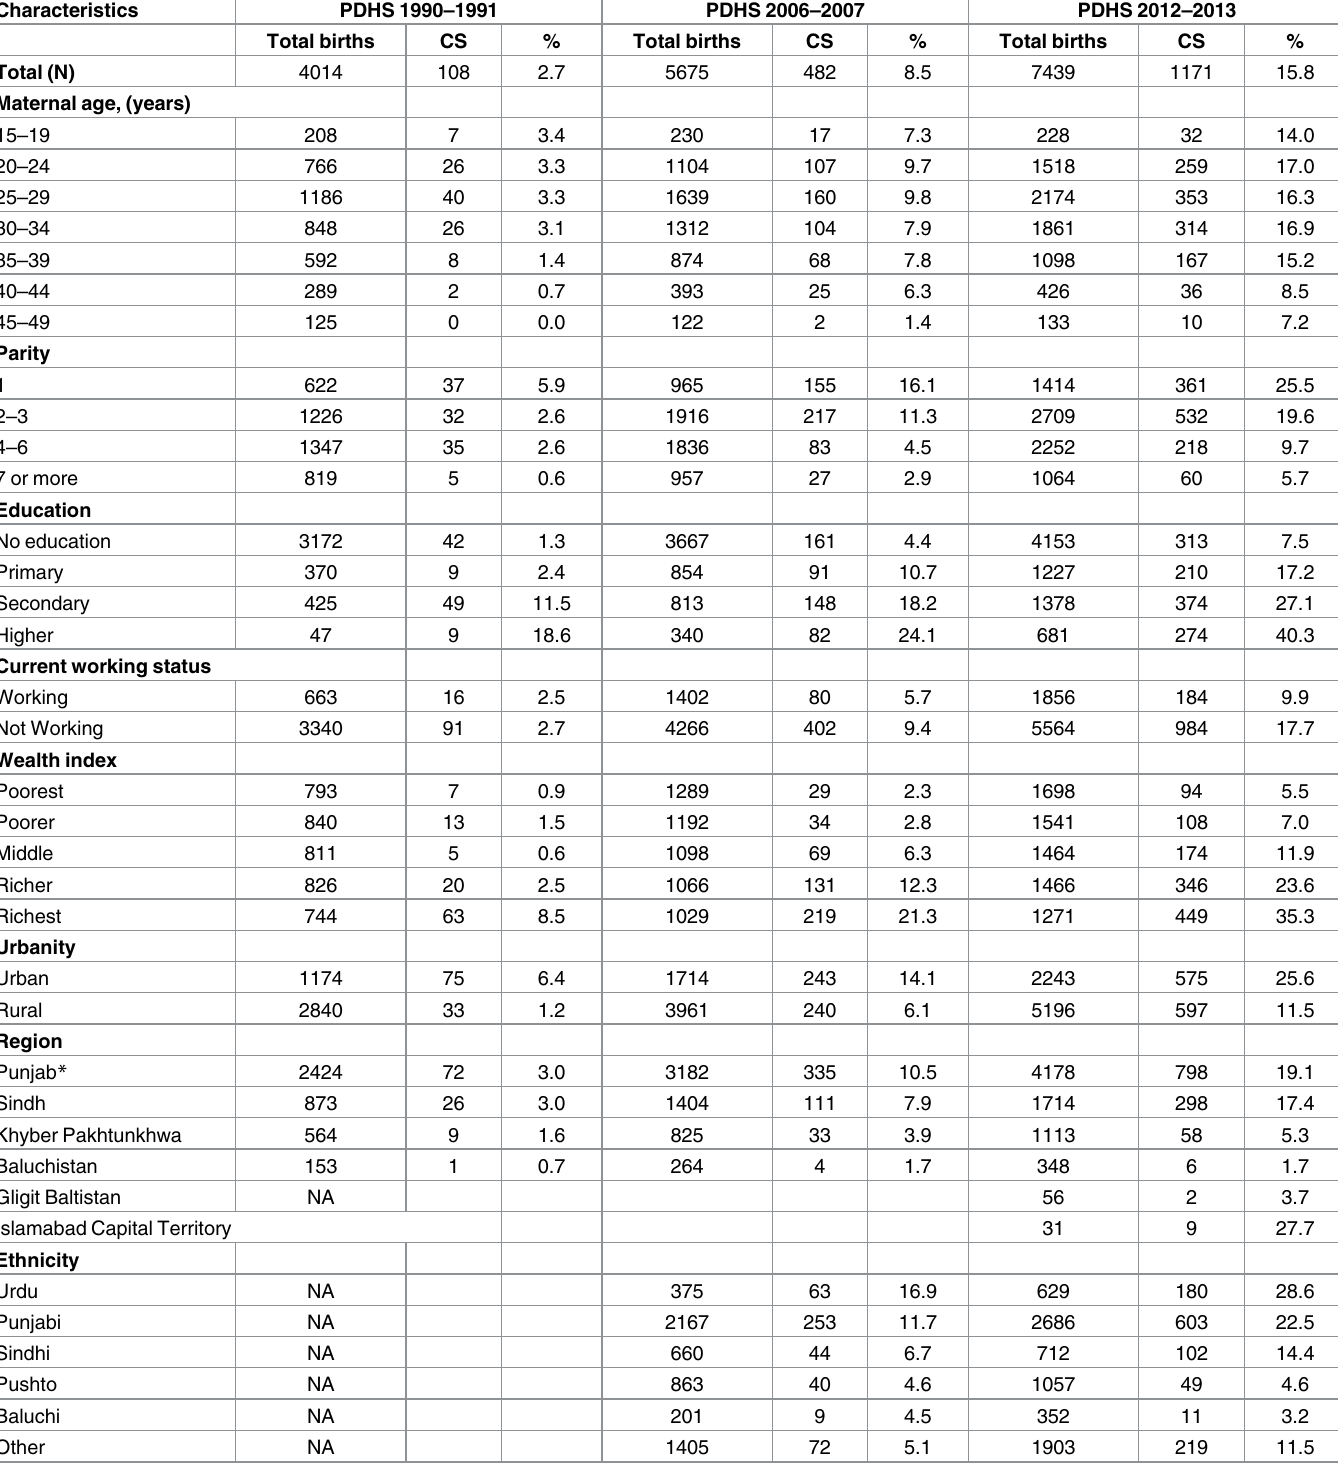
Table 2. Crude cesareansection rates (%) by socio-demographic characteristics from the Pakistan Demographic and Health Surveys(PDHS) in 1990–1991,2006–2007,and 2012–2013.